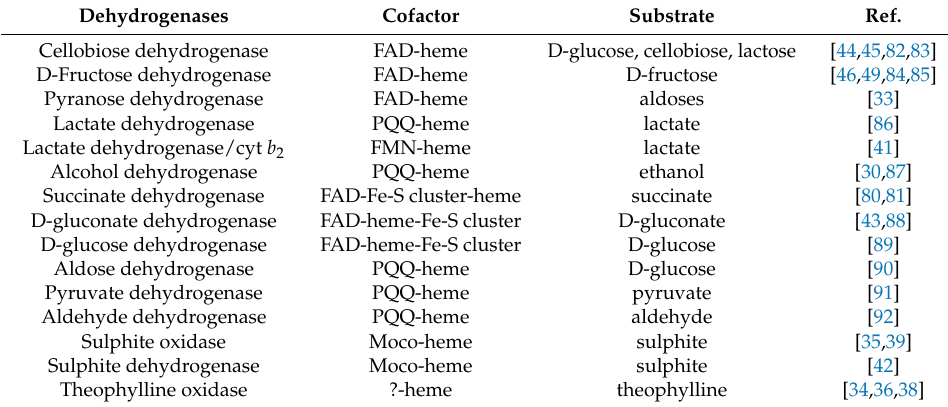
Table 1. Multicofactor oxidases/dehydrogenases for which Direct Electron Transfer (DET) reactions with electrodes have been shown. Dehydrogenases